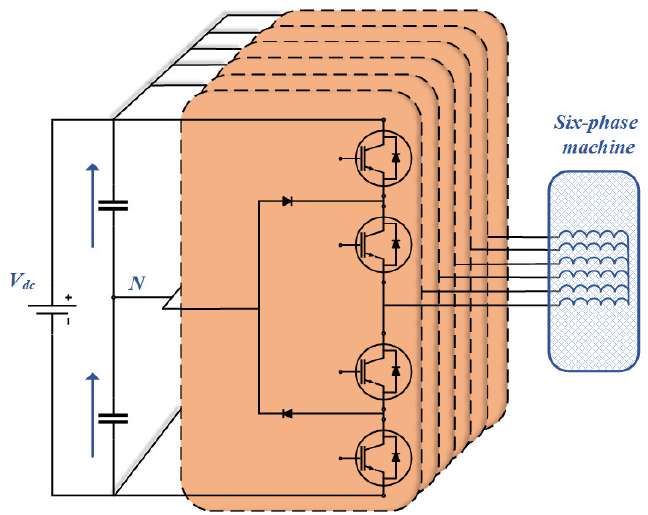
Figure 26. NPC-fed for a six-phase machine.